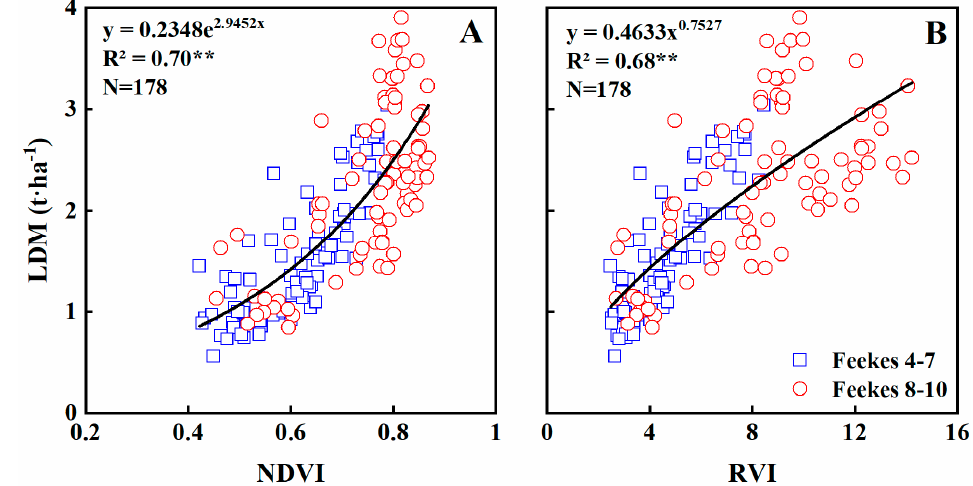
Figure 4. Quantitative relationships of NDVI ( A ) and RVI ( B ) to LDM in wheat varieties under varied N rates across all growth stages.